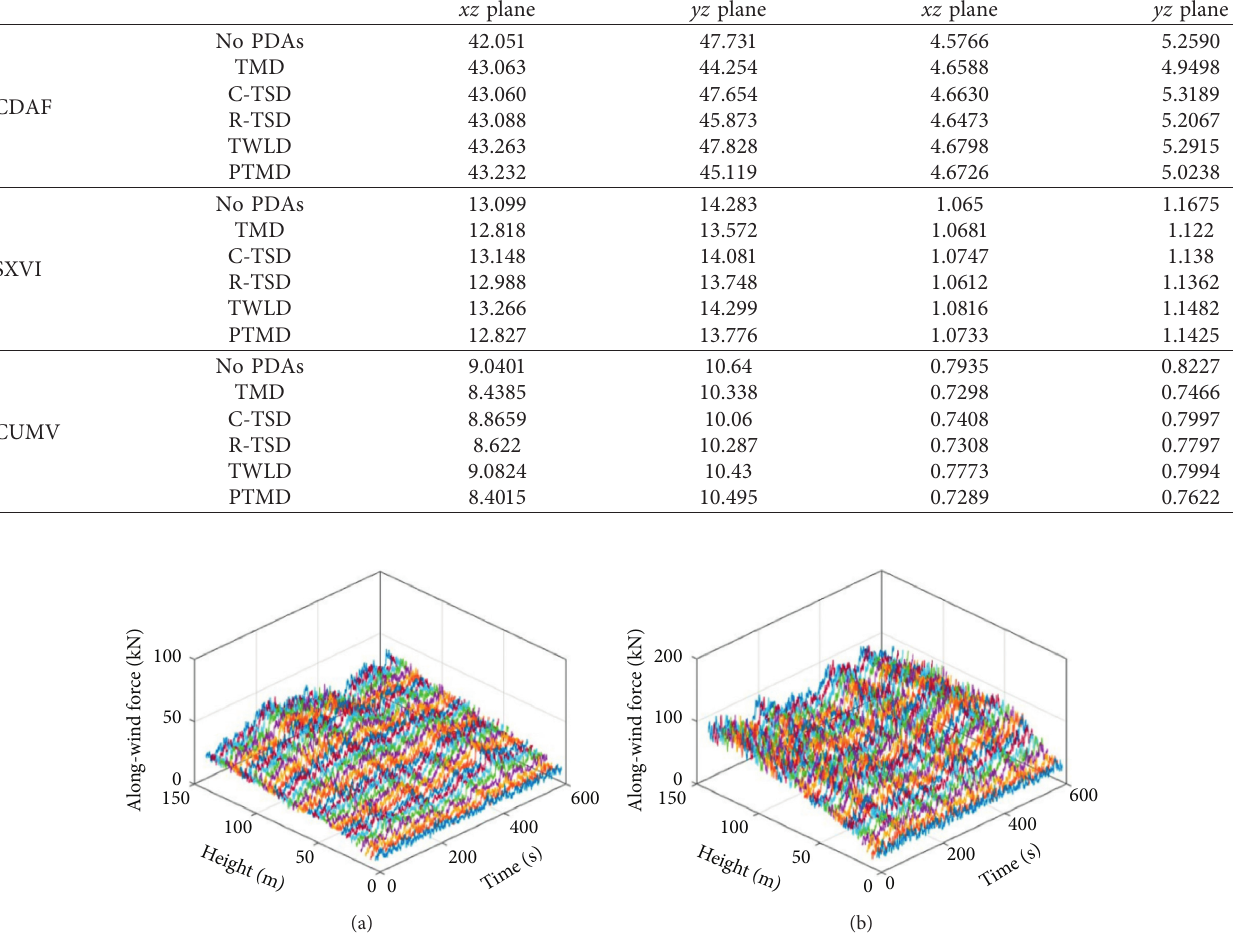
Figure 15: Along-wind forces for the building. (a) xz plane. (b) yz